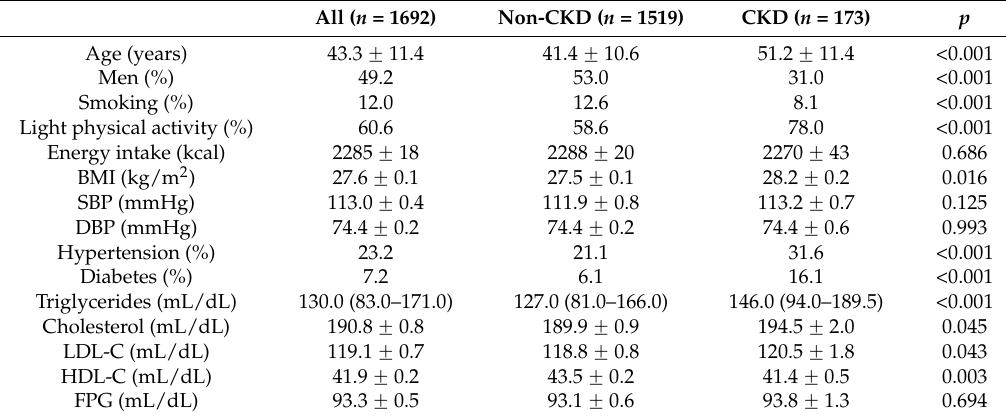
Table 1. Demographic and clinical characteristics of chronic kidney disease (CKD) and non-CKD subjects at baseline in the Tehran Lipid and Glucose